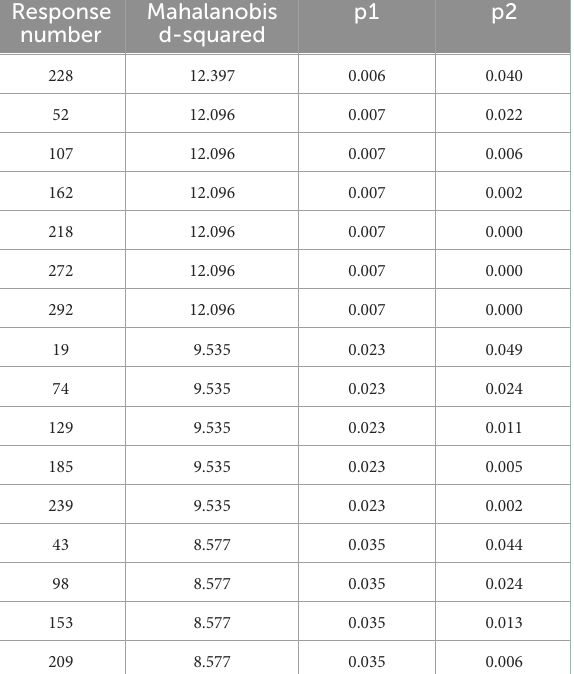
TABLE 2 Observations identified as